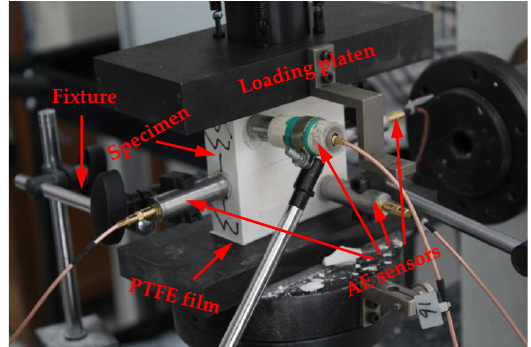
Figure 2. Arrangement of the AE sensors.